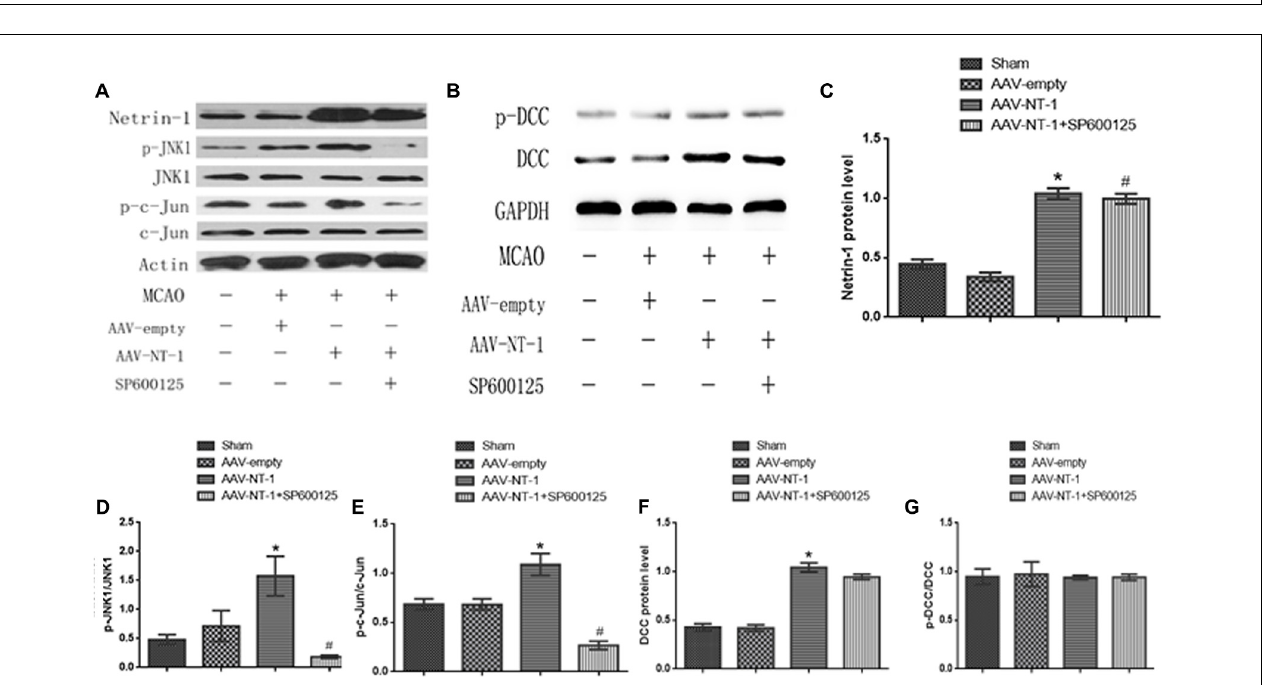
FIGURE 3 | Effects of Netrin-1 overexpression on the DCC/JNK1/c-Jun signaling pathway after the MCAO. (A) The representative image of western-blot analysis for Netrin-1, p-JNK1/JNK, p-c-Jun/c-Jun. Rats in each group were sacrificed at Day 14 after the MCAO. (B) The image of western-blot analysis for p-DCC/DCC. (C) Western-blot analysis of Netrin-1 ( n = 3), ∗ p < 0.001, as compared with the AAV-empty group, # p < 0.001, as compared with the AAV-empty group. (D) Western-blot analysis of p-JNK1 (n = 3), ∗ p < 0.05, as compared with the AAV-empty group, # p < 0.01, as compared with the AAV-NT-1 group. (E) Western-blot analysis of p-C-Jun ( n = 3), ∗ p < 0.01, as compared with the AAV-empty group, # p < 0.001, as compared with the AAV-NT-1 group. (F) Western-blot analysis of DCC ( n = 3), ∗ p < 0.001, as compared with the AAV-empty group. (G) Western-blot analysis of p-DCC ( n = 3).